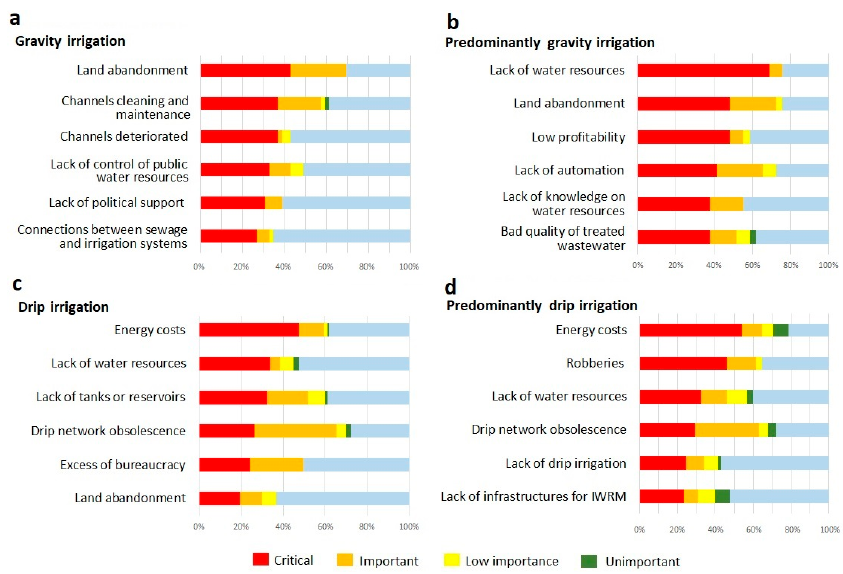
Figure 4. Problem assessment according to irrigation technique: evaluated in terms of percentage of total votes. ( a ) Gravity irrigation; ( b ) Predominantly gravity irrigation; ( c ) Drip irrigation; ( d ) Predominantly drip irrigation.